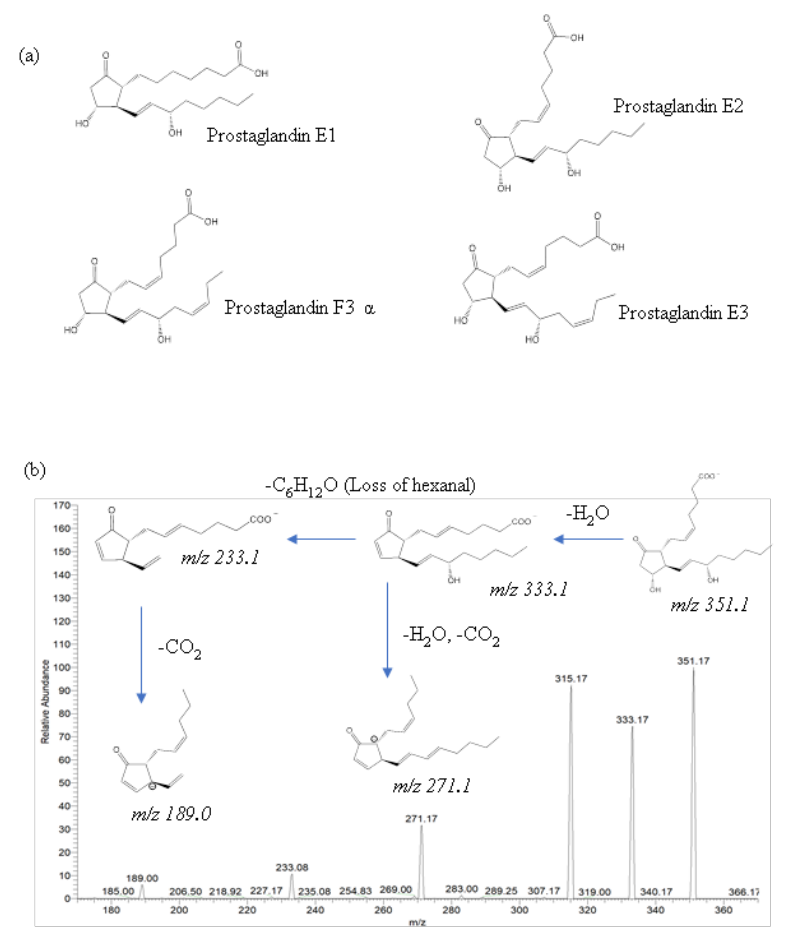
Figure 3. Chemical structure of four eicosanoids tested ( a ) and MS/MS spectrum of PGE2 showing its fragmentation pathway in the negative ion mode ( b ). Table 2. Identification and quantification of eicosanoids in salmon muscle